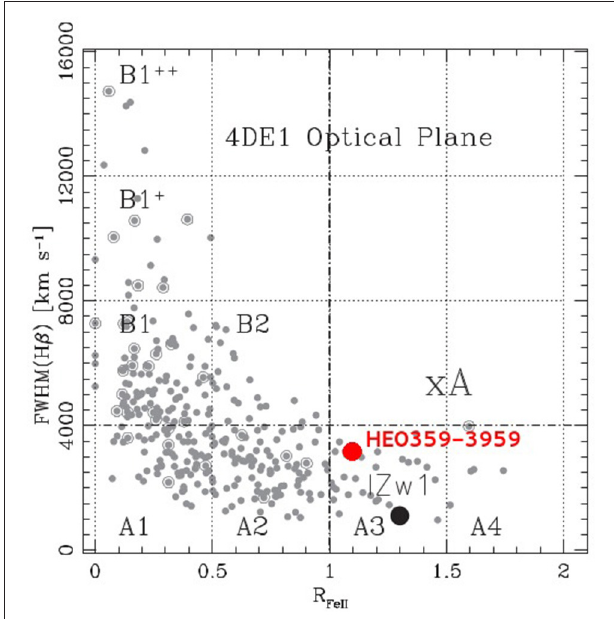
FIGURE 1 | 4DE1 Optical Plane reproduced from Marziani and Sulentic (2014). Gray points correspond to the sample of 470 bright low- z QSOs from Zamfir et al. (2010). The plane is divided in bins according to Sulentic et al. (2002). Extreme accretor population A sources (xA) are located in A3 and A4 bins. The black dot indicates the position of 1 Zw 1, the prototype of low- z xA sources. And, the red dot marks the location of HE0359-3959, an extreme xA source with high- z